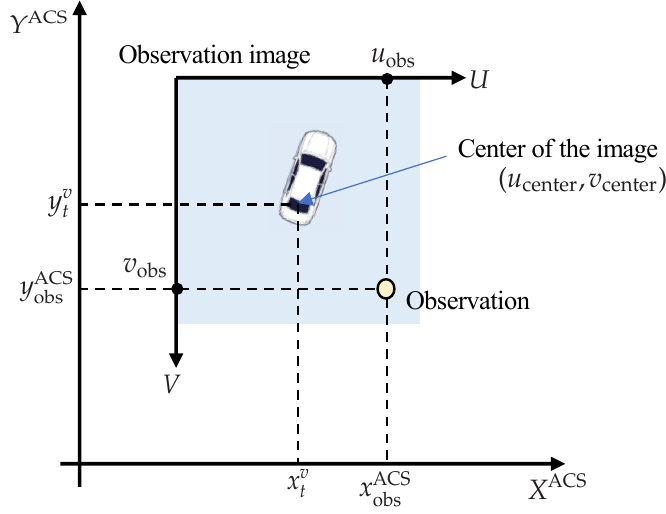
Figure 4. Mapping of a LiDAR observation to absolute coordinate